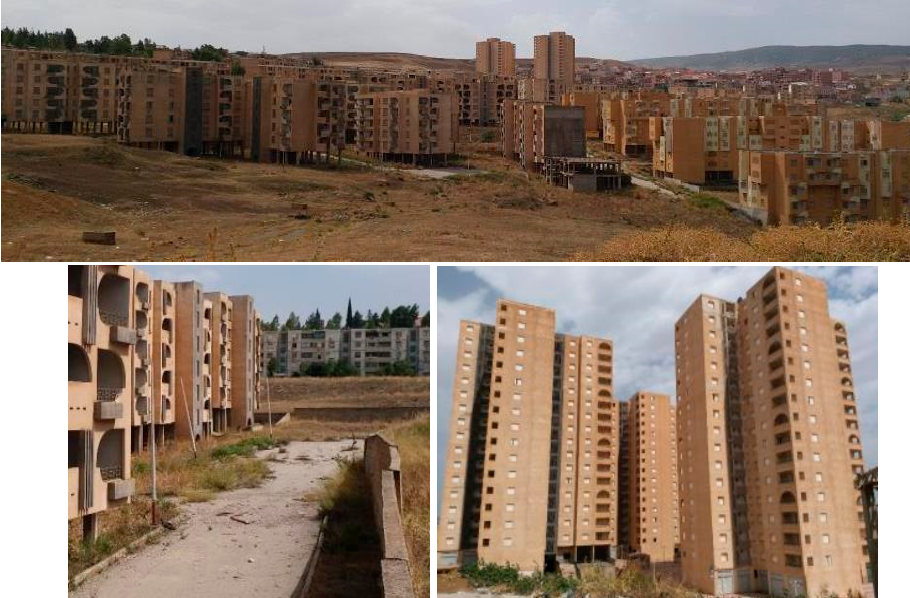
Figure 13. Building damaged at the Boussouf district. Geosciences 2019 , 9 , x FOR PEER REVIEW